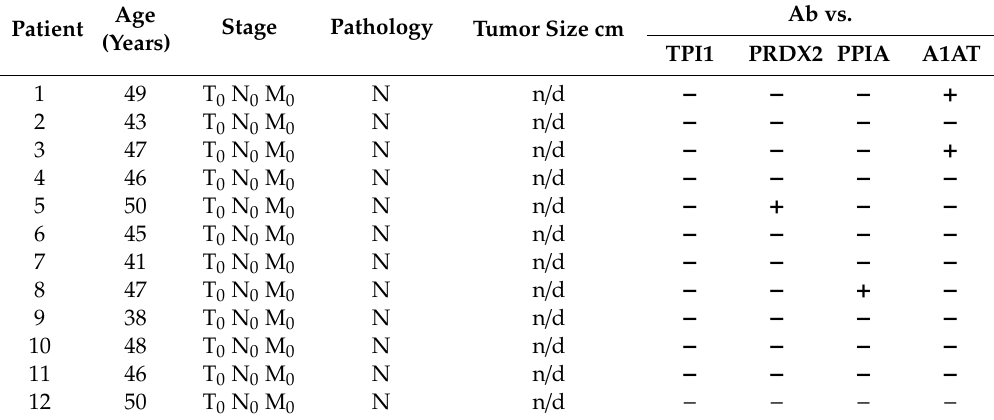
Table 2. Clinical characteristics of subjects without breast cancer and